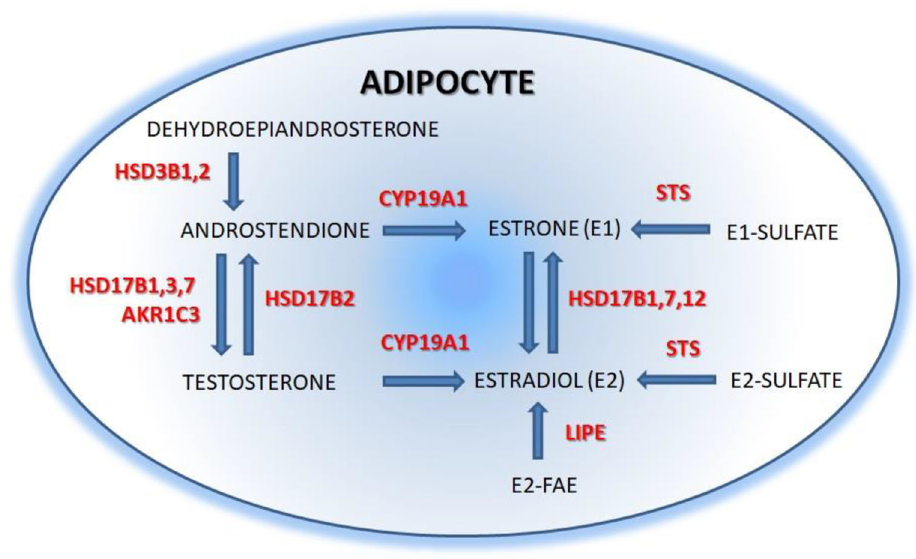
Figure 1. Synthesis of sex steroids in adipocyte (a simplified version). AKR1C3-aldo-keto reductase